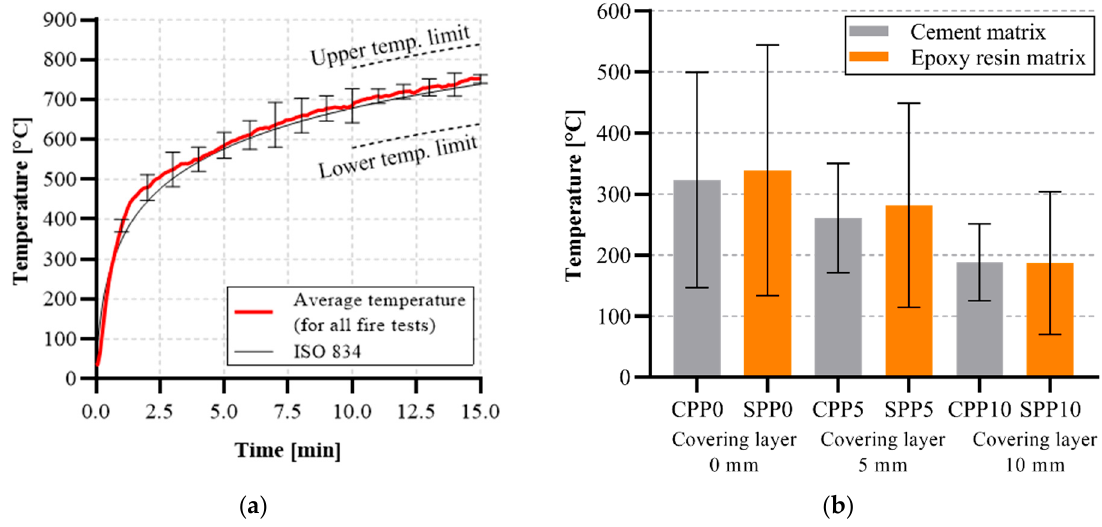
Figure 7. Measured temperature from the test furnace and tested specimens: ( a ) average temperature curve in the test furnace; ( b ) measured average temperatures of the specimens on the inner surface of the textile reinforcement for different covering layers and concrete mixture variants.